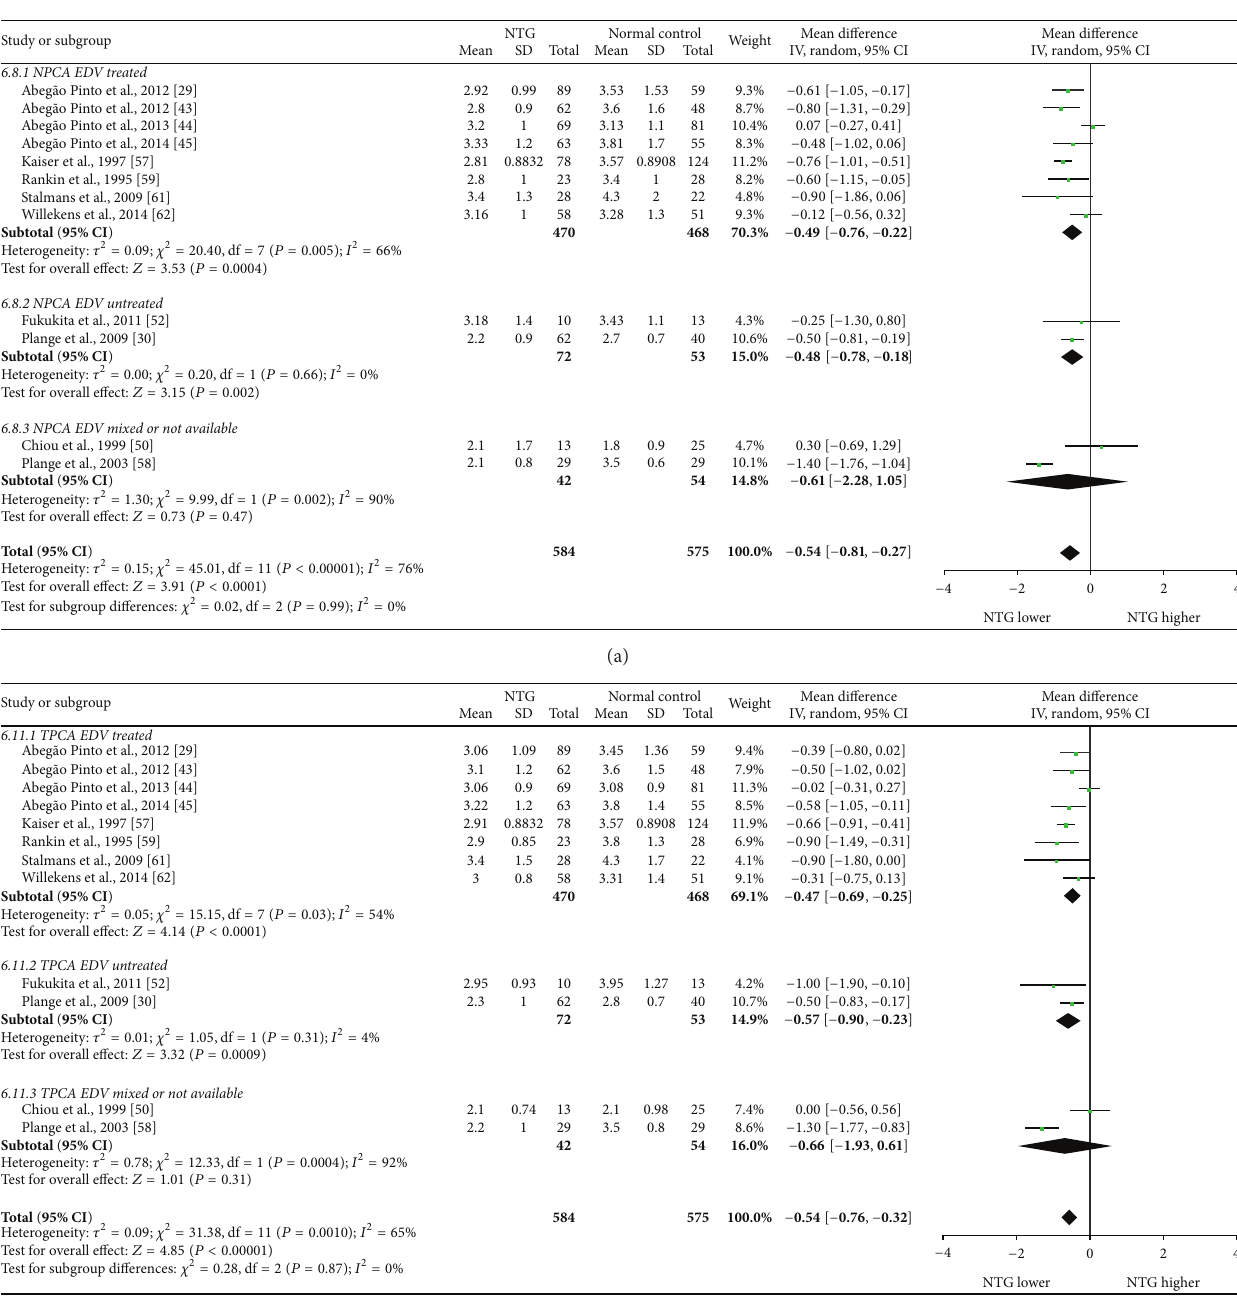
Figure 7: Forest plot of EDV in NPCA and